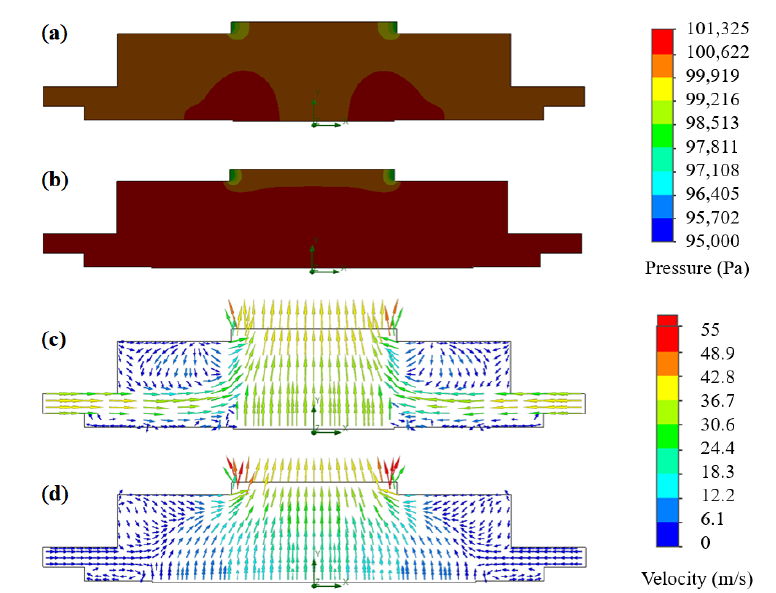
Figure 13. Cross-sectional views of steady-state fields at 20,530 rpm: ( a ) Pressure, 3 cm opening; ( b ) Pressure, 6 cm opening; ( c ) Velocity vectors, 3 cm opening; ( d ) Velocity vectors, 6 cm